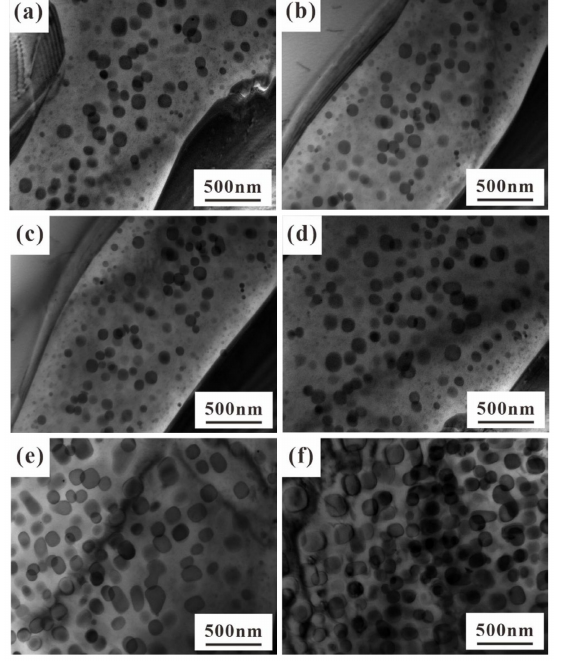
Figure 4. Bright-field TEM image of inter-dendritic regions of Al 0.6 CrFe 2 Ni 2 HEAs in different states: ( a ) as-cast; ( b ) cryogenic treatment for 4 h; ( c ) cryogenic treatment for 8 h; ( d ) cryogenic treatment for 12 h; ( e ) cryogenic treatment for 24 h; ( f ) cryogenic treatment for 48 h.